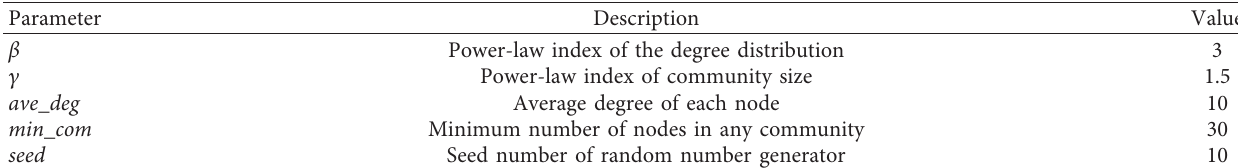
Table 1: The hyperparameters of the LFR